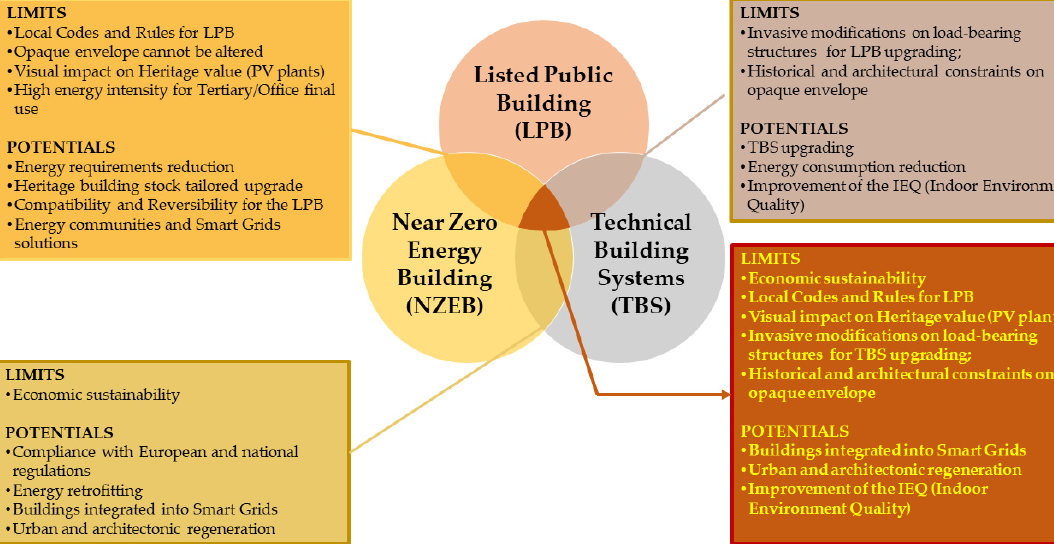
Figure 19. Impact diagram of limits and potentials on transforming LPB in nZEB.